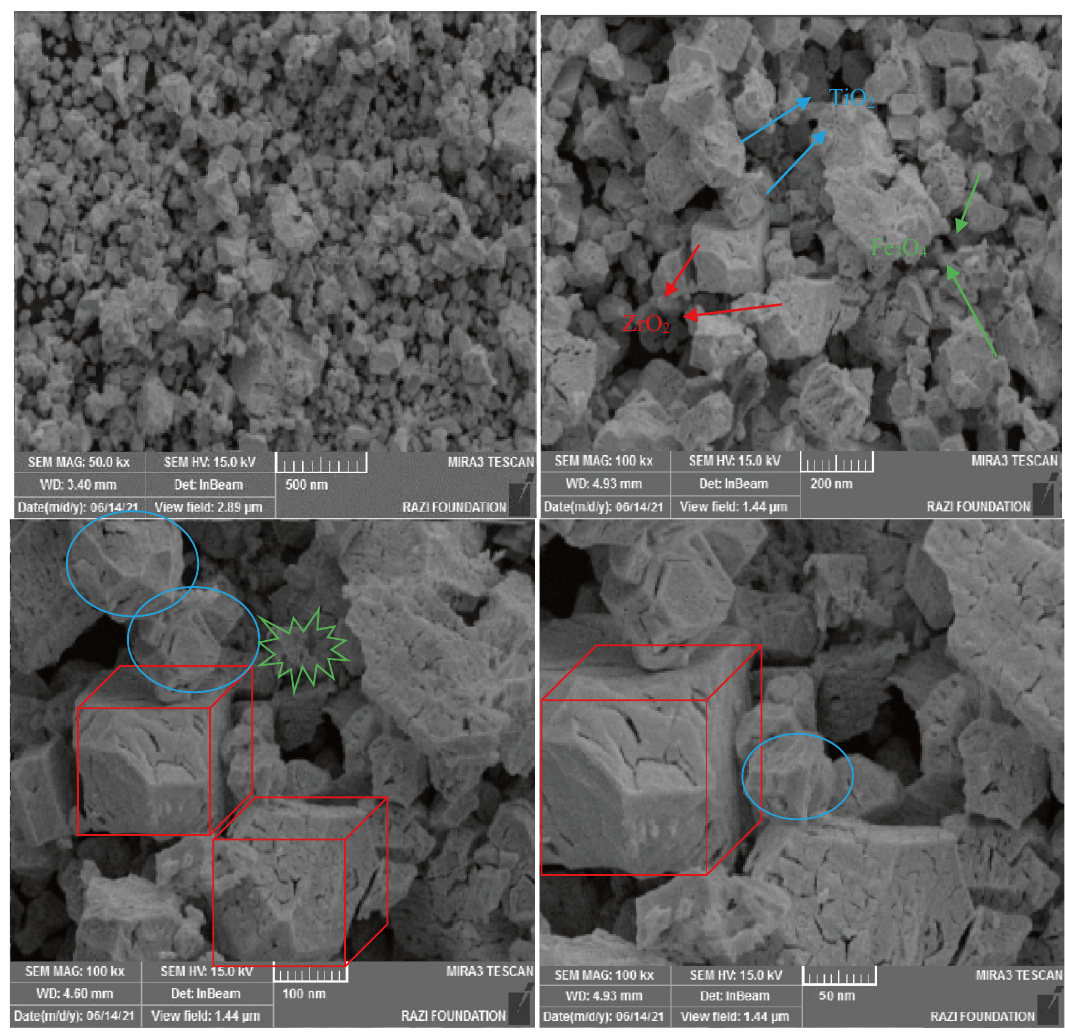
Figure 3. SEM image of ZrO 2 /TiO 2 /Fe 3 O 4 nanocomposite.